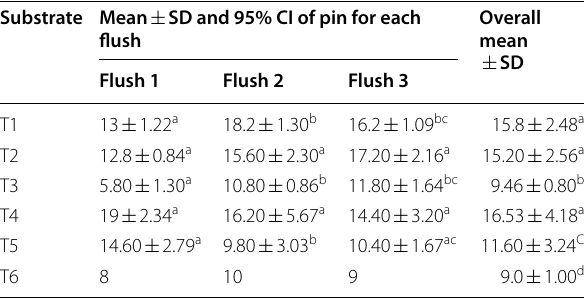
Mean values followed by different superscript letters within a row and columns are significantly different (p <